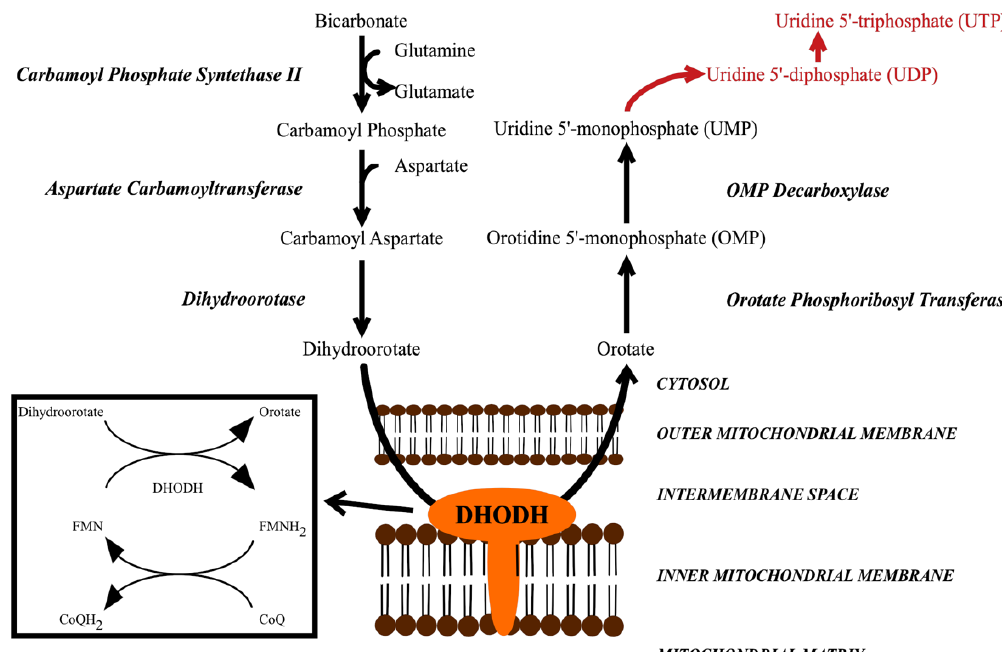
Figure 1. The de novo pyrimidine biosynthesis pathway, which leads to the formation of UMP. In subsequent steps, UMP is further converted into UDP and UTP (red words). DHODH catalyzes a redox reaction in which dihydroorotate is oxidized to orotate, while FMN is reduced to FMNH2, which is then re-oxidized by CoQ (ubiquinone). DHODH = dihydroorotate dehydrogenase.